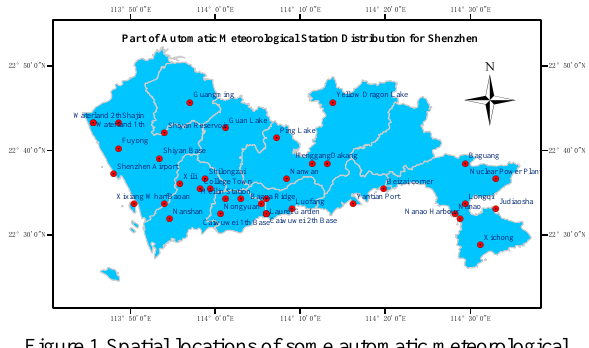
Figure 1.Spatial locations of some automatic meteorological stations in Shenzhen